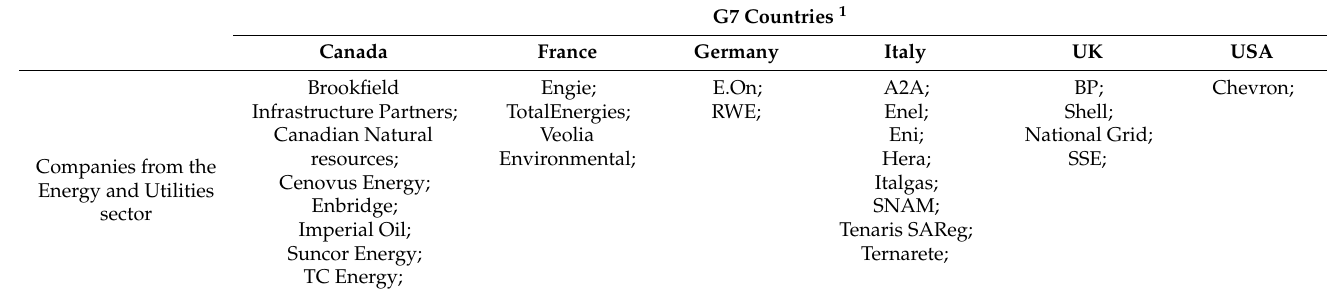
Table 2. List of the surveyed Energy and Utilities companies from individual stock exchange indica- tors in countries of the G7